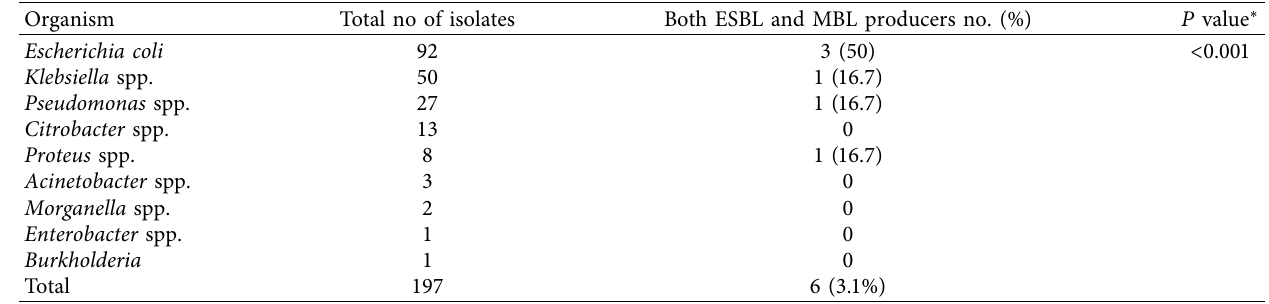
Table 6: ESBL and MBL producers among the various